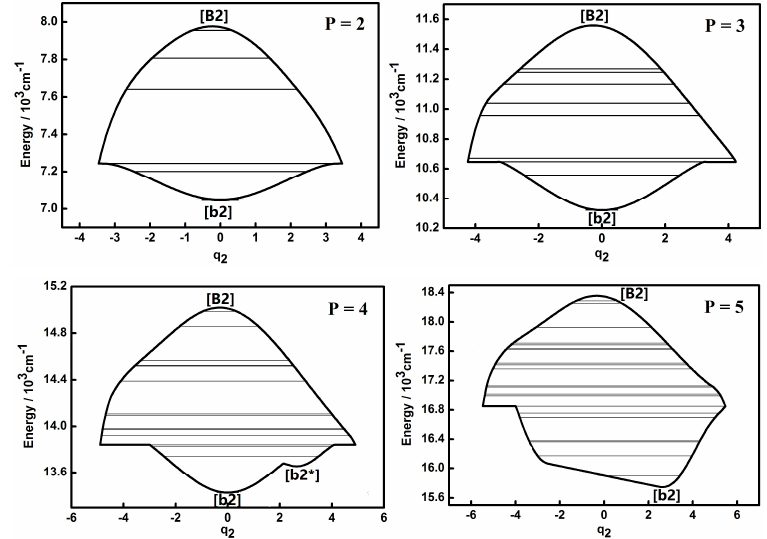
Figure 6. Dynamic potentials of the non-integrable HOCl system (obtained with H ( q 1 , p 1 , q 2 , p 2 , P ), q 2 coordinate) with P = 2, 3, 4, 5, and the energy levels included in the dynamic potential are shown by the lines.